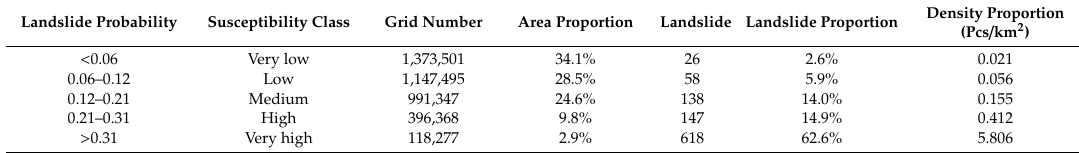
Table 5. Statistic result of landslide susceptibility in di ff erent classes of